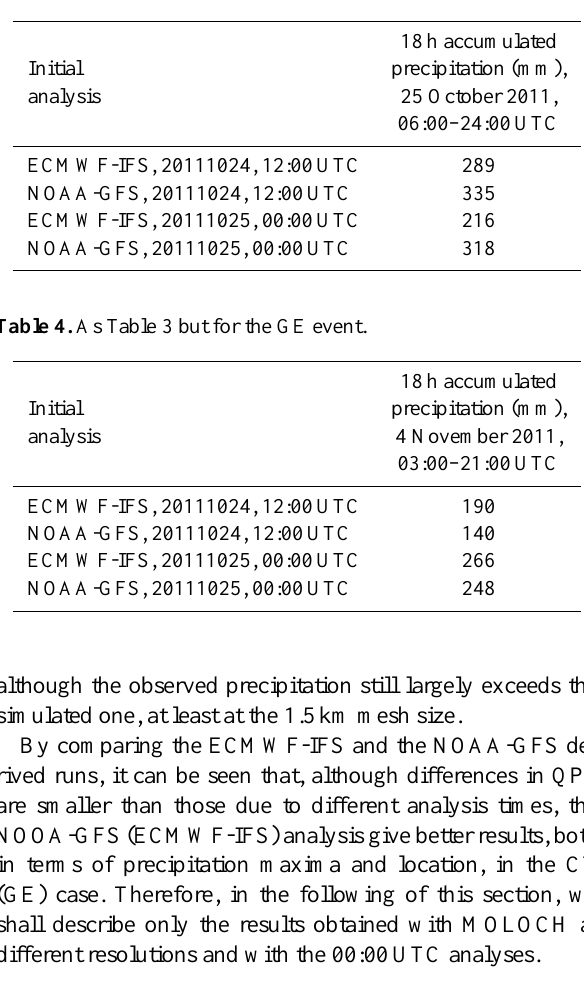
Table 3. Maxima of precipitation in the MOLOCH 1.5km runs, for the CT event. Initial conditions (for BOLAM) are listed in the left column.